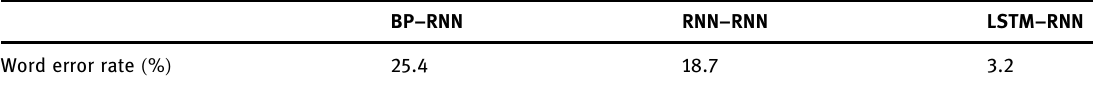
Table 2: The word error rate of the three machine translation algorithms for the translation of English text